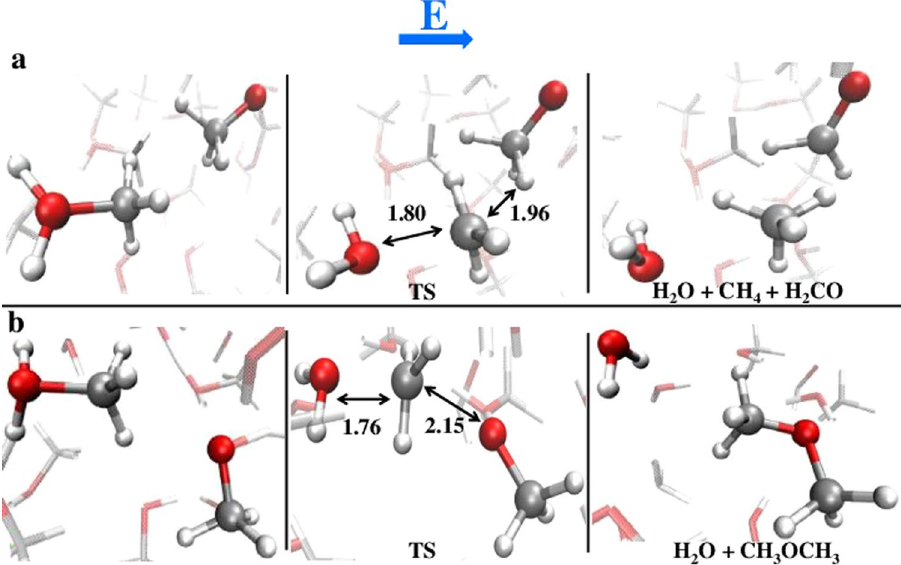
Figure 4. A twofold reaction channel. Depending on the mutual orientation of methoxide CH 3 O − and methyloxonium CH 3 OH 2 + , the reaction proceeds yielding either formaldehyde, methane, and water ( a ) or DME and water ( b ). In the central panels, the transition states of both reactions, obtained by means of a committor analysis performed at 300 K and in presence of field strengths of . 0 55 V/Å ( a ) and . 0 60 V/Å ( b ), are